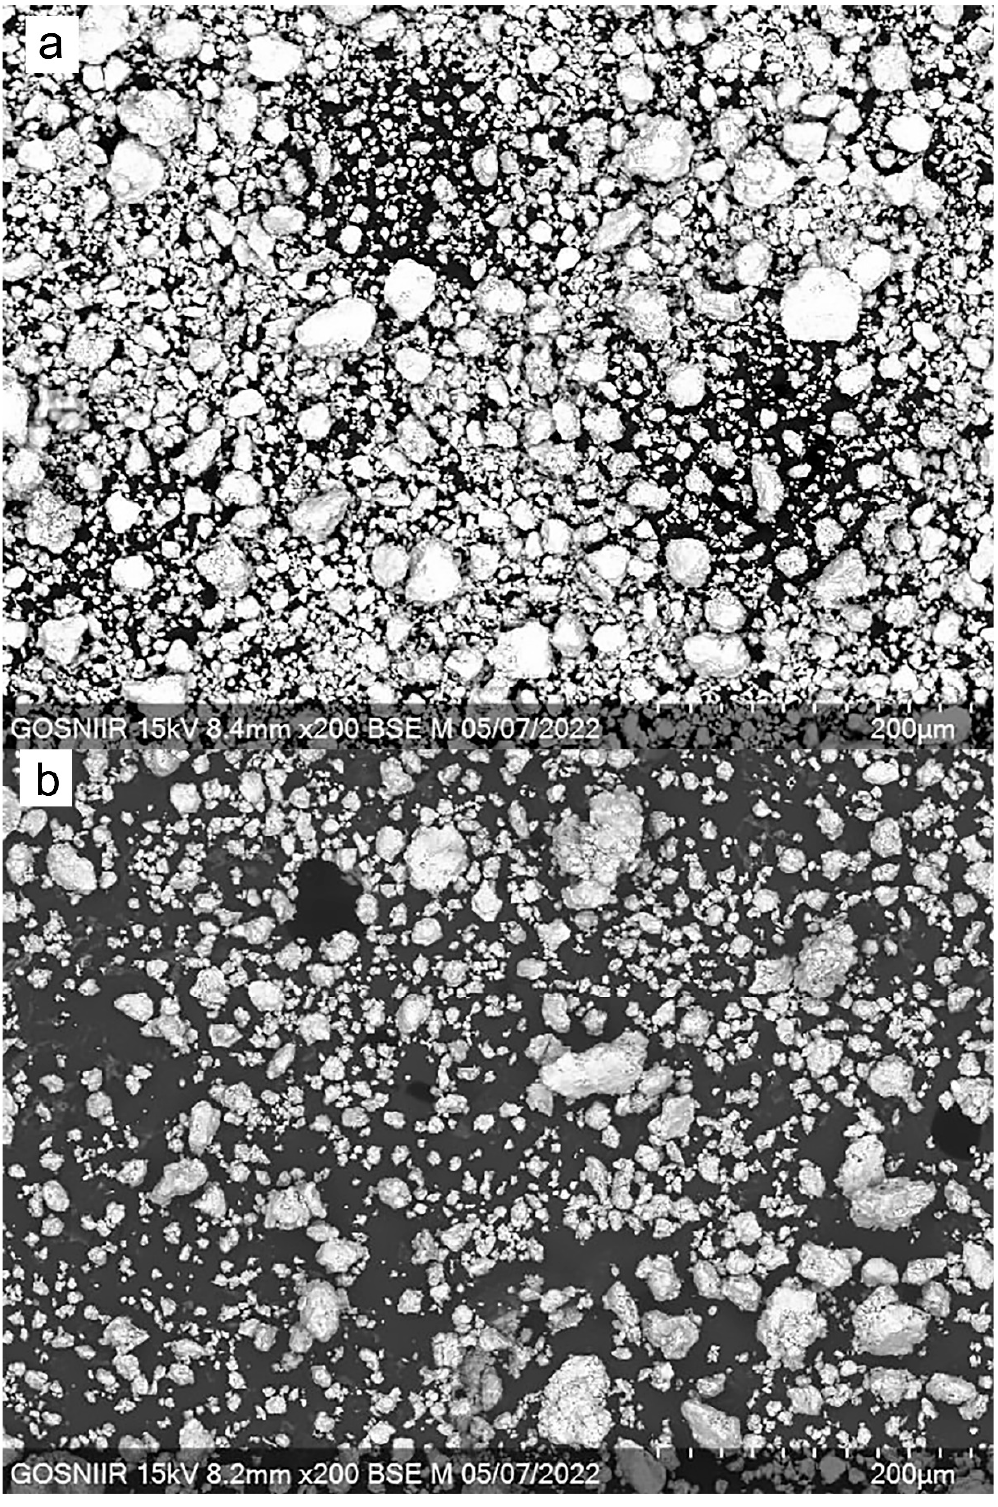
Figure 3. Morphology of the powders after 5 h of mechanical alloying: ( a )—35Fe30Cr20Ni10Mo5W; ( b )—30Fe30Cr20Ni10Mo10W.